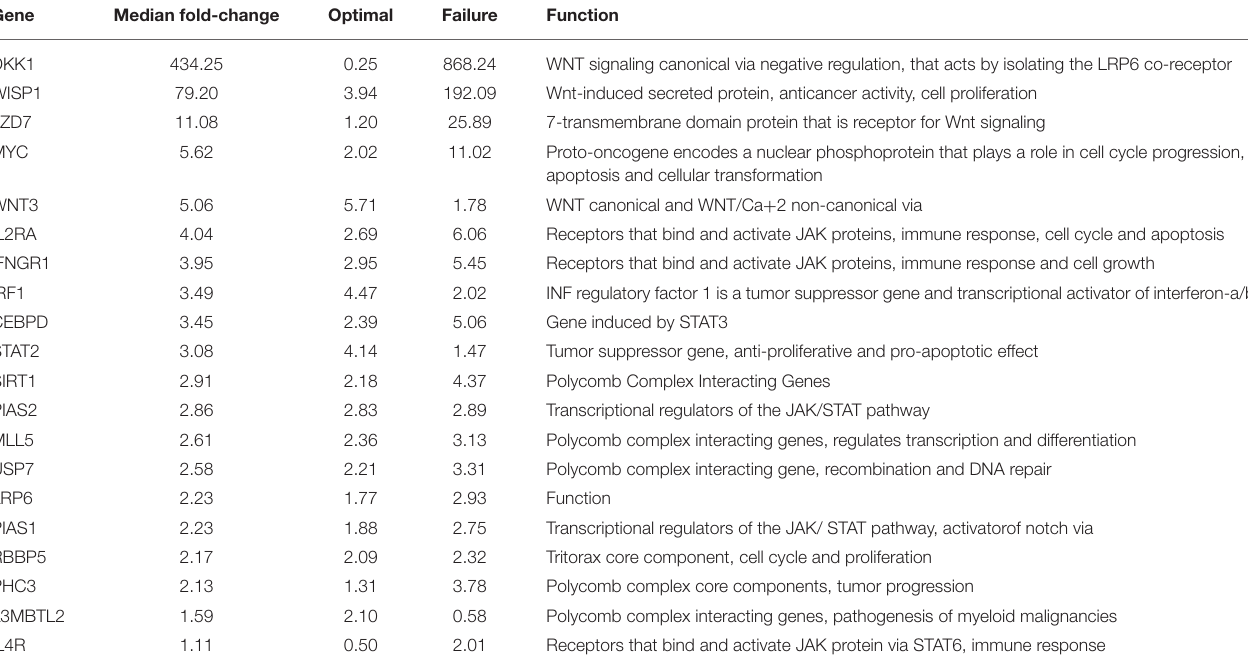
TABLE 2 | Gene expression de-regulation of selected genes and function. Gene Median fold-change Optimal Failure